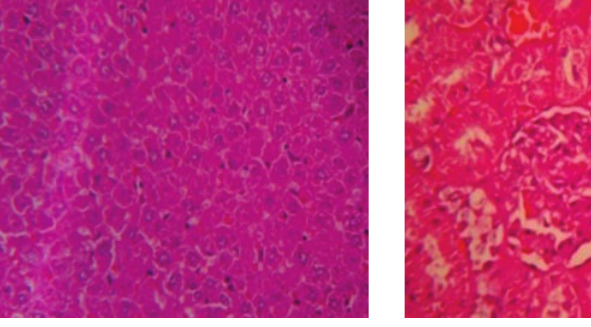
Figure 5. Kidney of control group showing normal capsule and glomeruli.